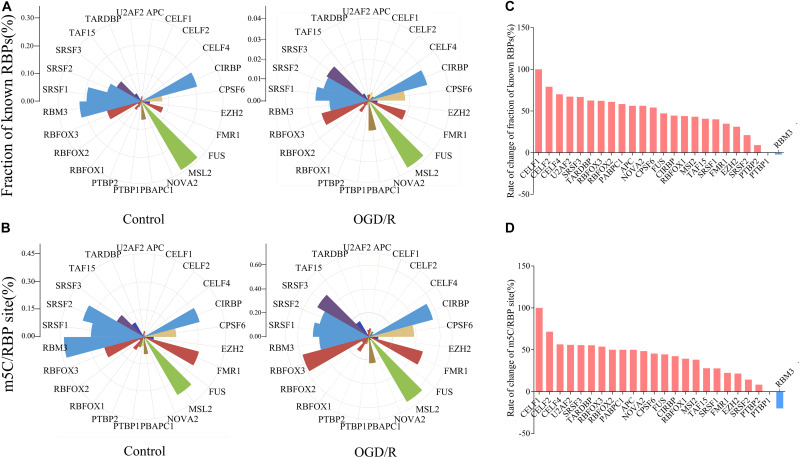
Rose diagrams depict an overlap of mRNA m5C sites with RBP-binding sites available in POSTAR. (A) Fraction of binding sites overlapping with a m5C site for each particular RBP. Fraction of known RBPs = RBP binding sites overlapping with a m5C site/RBP binding sites. (B) The number of m5C sites overlapping with a binding site of a particular protein was normalized against the total number of m5C sites. m5C/RBP site = m5C sites overlapping with a RBP binding site/RBP binding sites. (C,D) Histograms present the difference between two groups. The result is the difference between the number of binding sites in the OGD/R group and the control group divided by the number of sites in the OGD/R group. (C, Fraction of known RBPs; D, m5C/RBP).